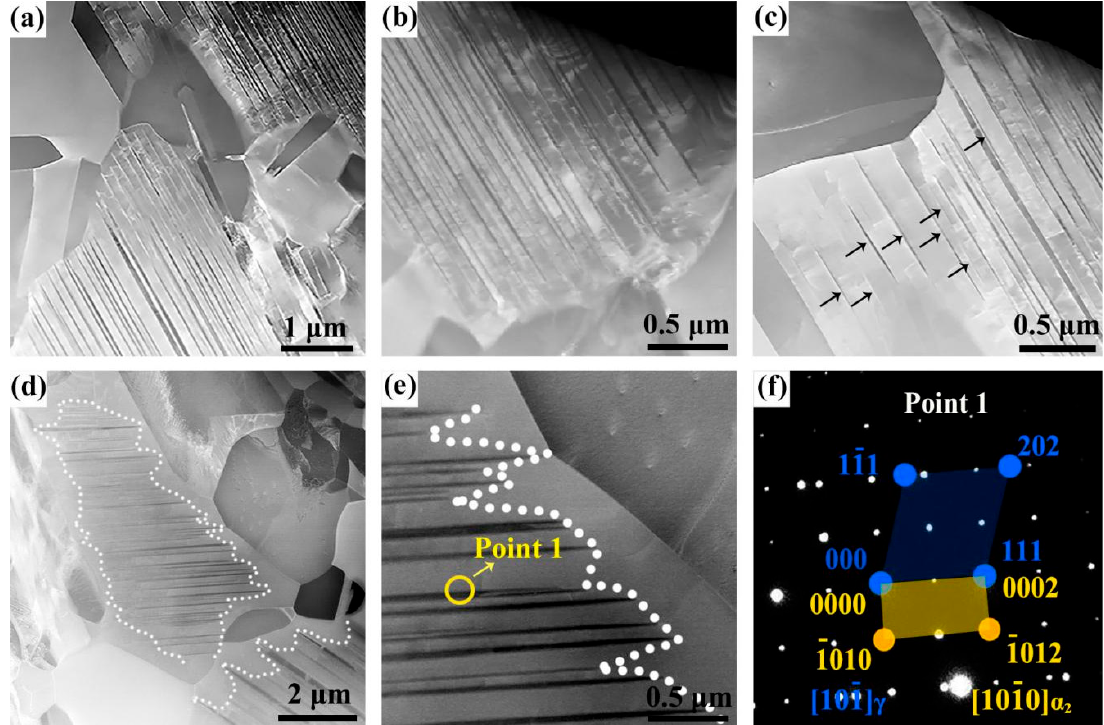
Figure 5. The high-angle annular dark-field (HAADF) images of initial isothermally forged TiAl ( a – c ) and HT-1 ( d , e ), where ( f ) is the selected area diffraction pattern from location 1 in ( e ).